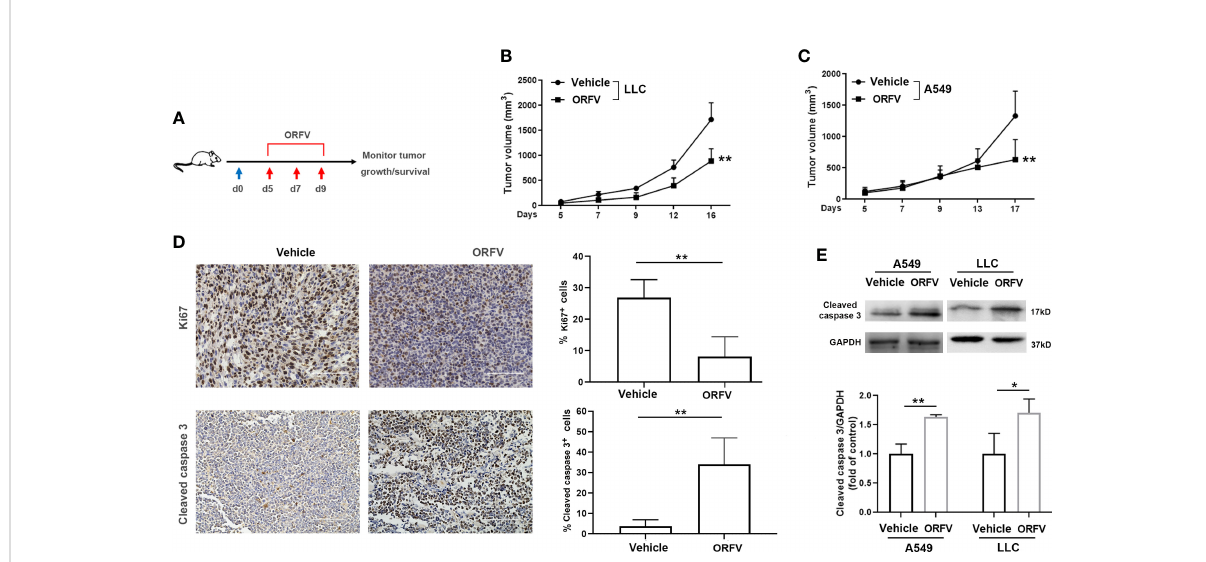
FIGURE 4 Intratumoral injection with ORFV NA1/11 inhibits tumor growth in vivo by promoting tumor cell apoptosis. (A) Treatment schema: A lung cancer model was established by subcutaneous injection with syngeneic lung cancer LLC (4× 10 5 ) or A549 cells (3× 10 6 ) into C57BL/6 mice or nude mice (n=6/group) at day 0 (blue arrow), respectively. When the tumors reached 50-100 mm 3 , the tumor-bearing mice were randomized and injected intratumorally with vehicle PBS as the controls or ORFV NA1/11 (red arrows). (B, C) The dynamic growth of LLC and A549 tumors in mice was measured longitudinally. (D) Representative images of tumor sections following immunohistochemical staining with anti-Ki67, or anti- cleaved caspase 3. Scale bars =100 m m. Quantitative analysis of Ki67 + tumor cells and cleaved caspase 3 + tumor cells in tumor tissues were counted in fi ve fi elds (400×) from each group and the data are the average number of positive cells per fi eld. (E) Western blotting analyses of the relative levels of cleaved caspase 3 in tumor tissues of mice that had been treated with PBS or ORFV NA1/11. Data are expressed as the mean ± SD of each group from three separate experiments. *P<0.05,